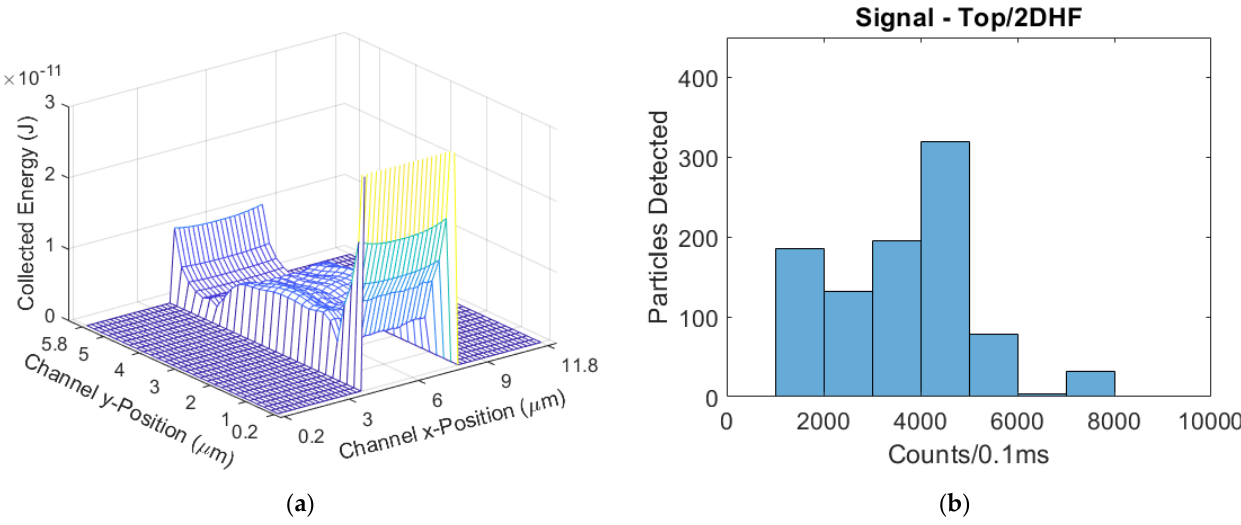
Figure 13. ( a ) The modeled excitation region for the top-illuminated biosensor with a 2DHF flow regime; ( b ) The simulated signal distribution, with a skew further to the right than the parabolic flow device.